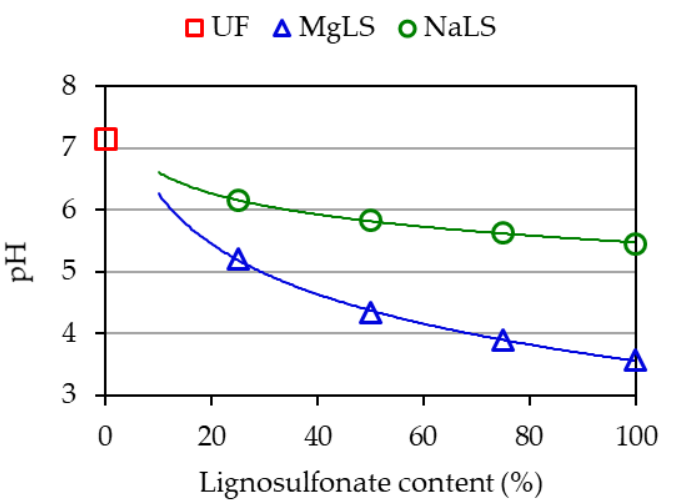
Figure 3. pH of freshly prepared uncured UF compositions as a function of lignosulfonate content.